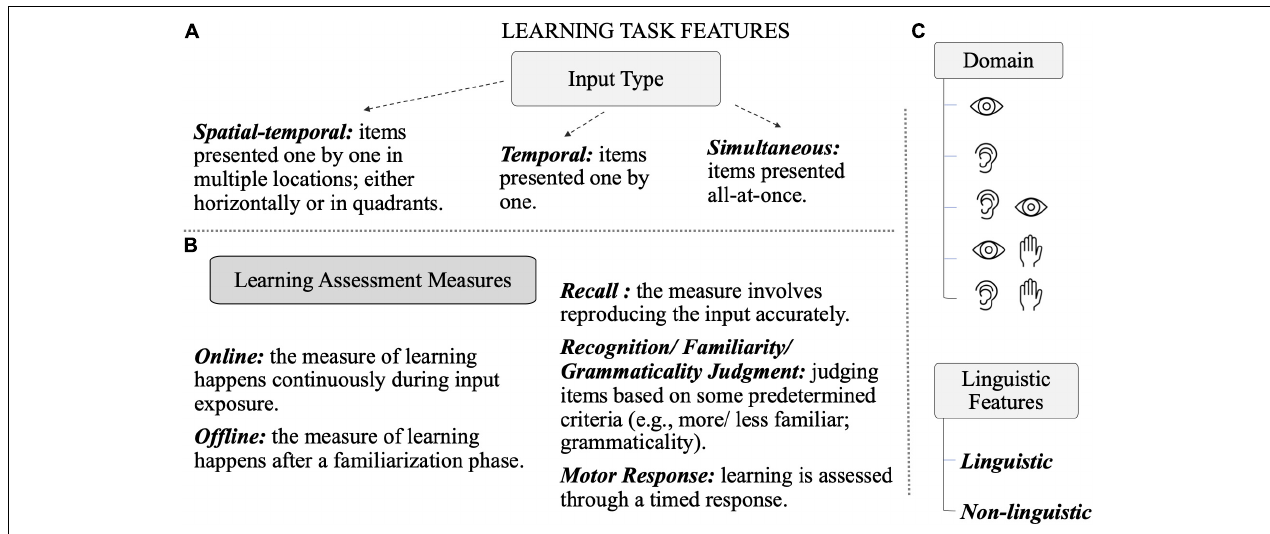
FIGURE 3 | Common task features of statistical learning paradigms. (A) Schematic of different input types commonly used in tasks, each is accompanied by a short description. (B) Different learning assessment measures used in statistical learning tasks along with short descriptions. (C) Sensory domains from top to bottom: visual, auditory, auditory-visual, visual-motor, auditory-motor; and two types of task stimulus features: linguistic or